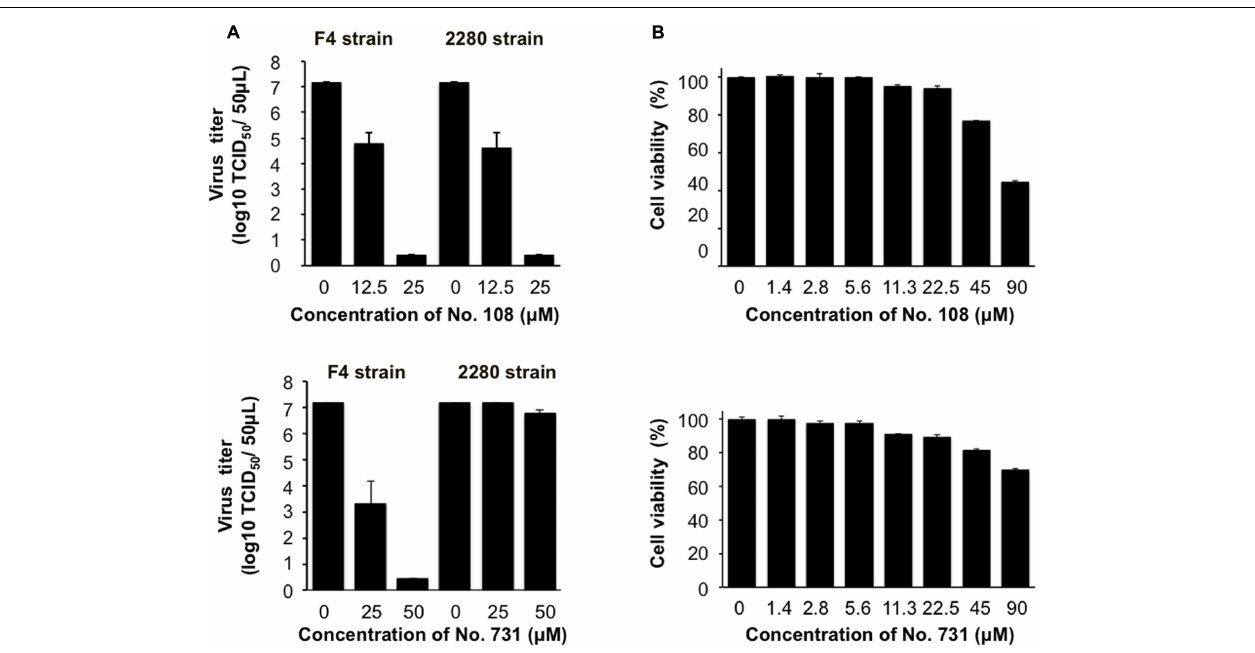
FIGURE 4 | Evaluation of anti-FCV activity of the candidate molecules. (A) Dose-dependent inhibitory effect of compound No. 108 and No. 731 on the FCV growth in CRFK cells. CRFK cells were infected with the FCV F4 strain or FCV 2280 strain at a MOI of 0.0001. The cell culture supernatants were collected at 40 h post-infection in the presence of compound No. 108 (12.5 or 25 µ M) or DMSO only, and the virus titer was determined as TCID 50 /50 µ L. Upper panel: compound No. 108 that has structural portions mimicking the P3 and P4 sites of authentic substrate. Lower panel: compound No. 731 that is a No. 108 derivative that has structural portion mimicking the P3 site. (B) Evaluation of the cytotoxicity of compound No. 108 and No. 731. The cytotoxic effects of the No. 108 on the CRFK cells were measured by a CellTiter Glo Luminescent Cell Viability Assay Kit (Promega) at 48 h after compound